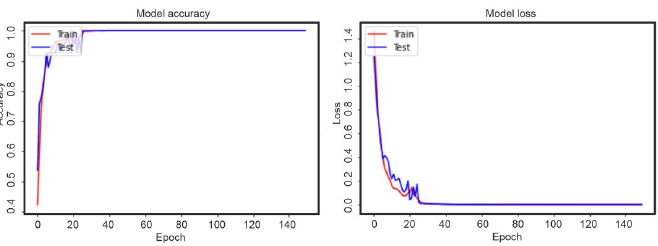
Fig 8. Accuracy of the model and the loss function for right-handed punches.